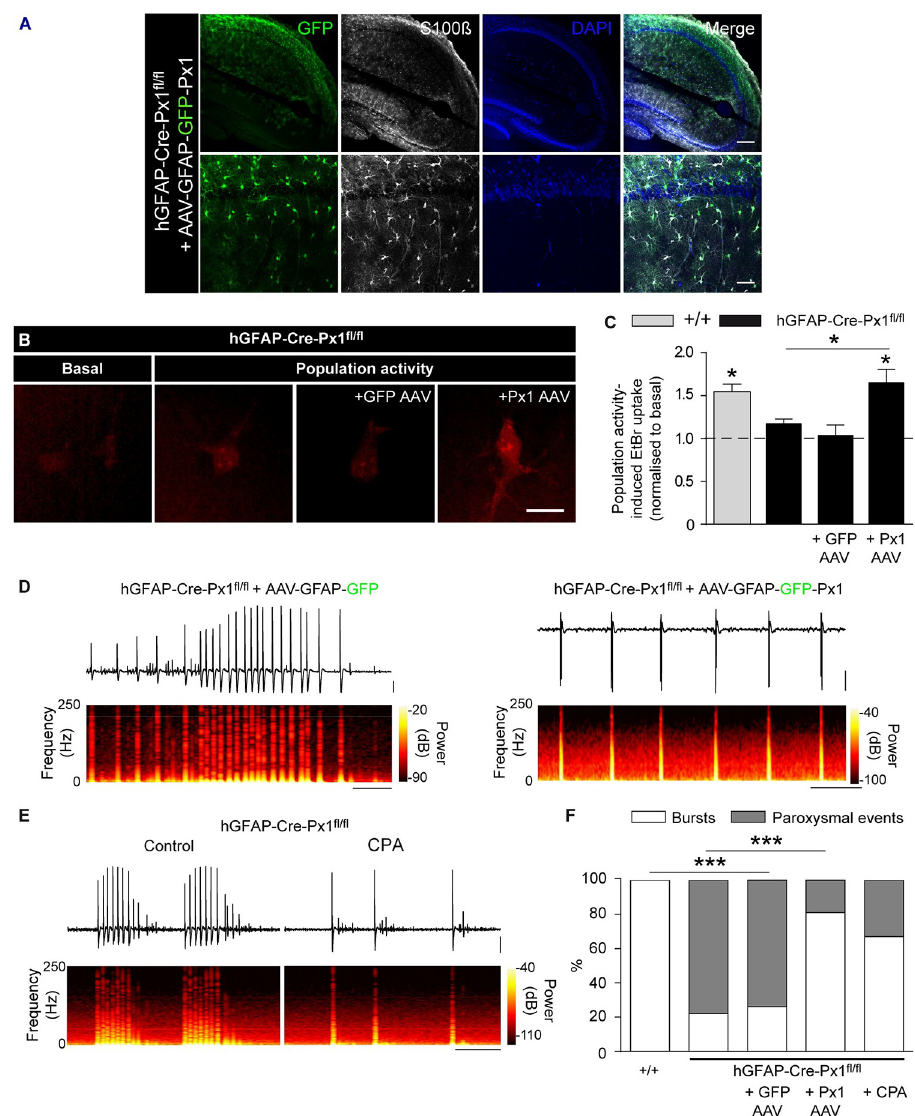
Fig 6. Restoring Px1 expression in astrocytes or pharmacological activation of A1Rs rescue bursting patterns in hGFAP-Cre-Px1 fl/fl mice. ( A ) Representative confocal images of GFP (green), S100 (grey), and DAPI (blue) immunolabelling in hippocampal slices from hGFAP-Cre-Px1 fl/fl mice infected with AAV-GFAP-GFP-Px1 (Px1 AAV; see Materials and methods). Scale bars, upper panel, 200 μ m; lower panel, 50 μ m. ( B ) Astroglial EtBr uptake in basal or population activity conditions in hGFAP-Cre-Px1 fl/fl astrocytes without or with GFP AAV and Px1 AAV expression. Scale bar, 10 μ m. ( C ) Quantification of astroglial activity-dependent EtBr uptake normalised to control conditions in slices from +/+ and hGFAP-Cre-Px1 fl/fl mice injected or not with GFP AAV and Px1 AAV ( n = 5 and 5 mice, respectively; Student t test). ( D ) Representative trace of neuronal network activity recorded in hippocampal slices from hGFAP-Cre-Px1 fl/fl mice infected with GFP AAV (top; n = 19 slices from 4 mice) and Px1 AAV (bottom; n = 21 slices from 4 mice). The corresponding time-frequency plots are shown under the traces. Scale bar, 10 s, 100 μ V. ( E ) Representative traces of neuronal network activity in hGFAP-Cre-Px1 fl/fl mice before and during application of the A1R agonist CPA (300 nM; n = 6 slices from 3 mice). The corresponding time-frequency plots are shown under the traces. Scale bar, 25 s, 100 μ V. ( F ) Proportion of bursts and paroxysmal events recorded in hippocampal slices from +/+, hGFAP-Cre-Px1 fl/fl , hGFAP-Cre-Px1 fl/fl + GFP AAV, hGFAP-Cre-Px1 fl/fl + Px1 AAV, and hGFAP-Cre-Px1 fl/fl + CPA mice. Asterisks indicate statistical significance ( � p < 0.05, �� p < 0.01). The data underlying this figure can be found in the S1 Metadata F tab.